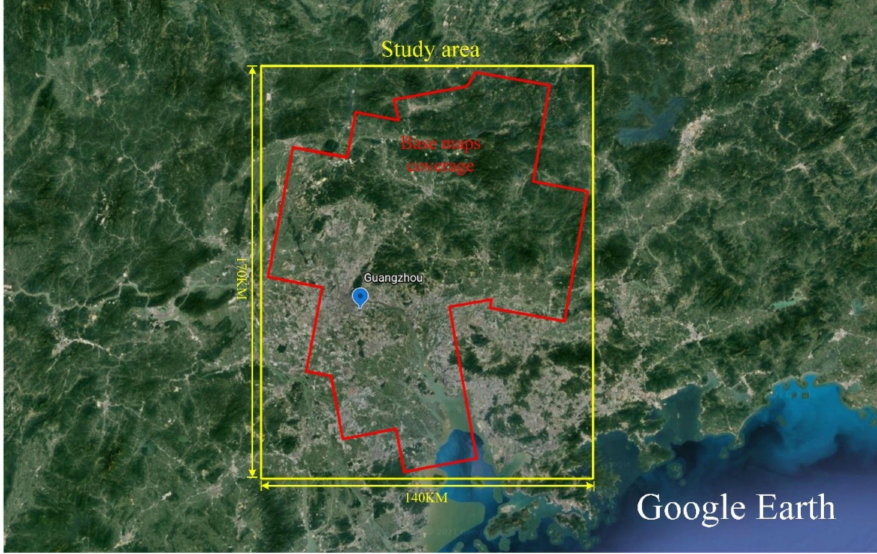
Figure 14. The study area (framed with the yellow rectangle) and the areas (marked by the red polygon) covered by SAR reference images.